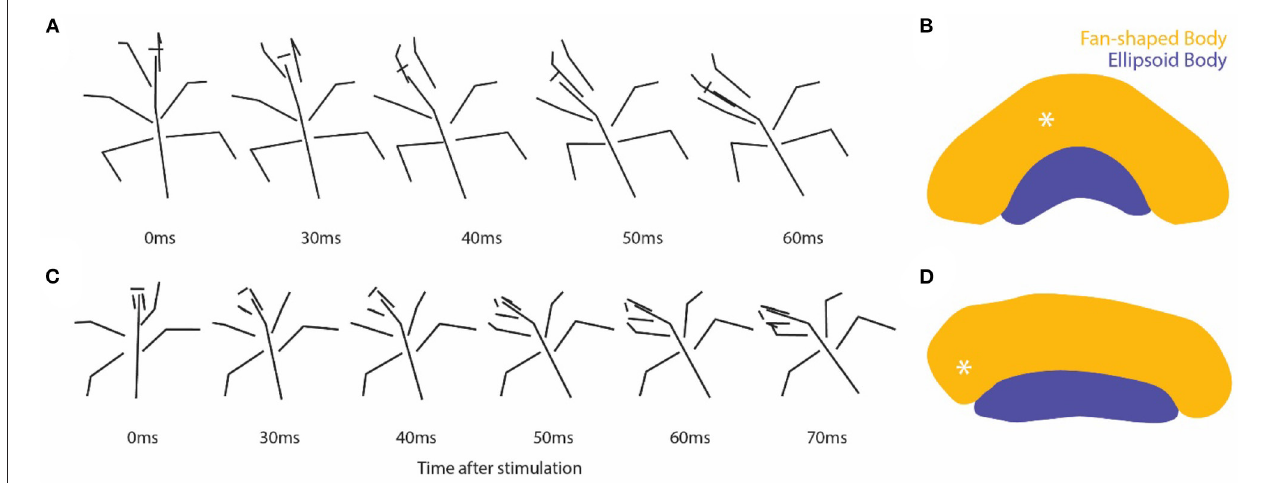
FIGURE 6 | (A,C) Stick figures drawn from individual video frames at the time of stimulation through the tetrodes and 4–6 frames 10ms apart following that point. (B,D) Diagrams of sections in the CX showing the location of tetrode tips (asterisk) for each